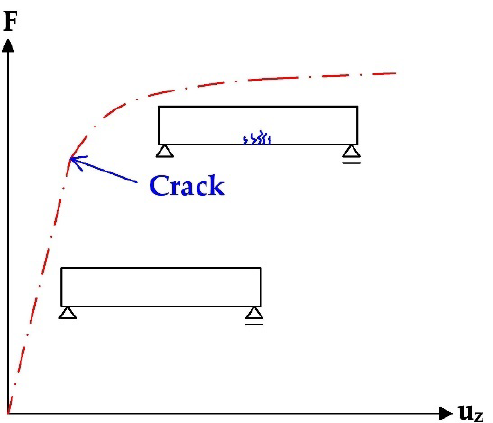
Figure 1. Normal stress distribution in PC member—before sawing ( a ); after sawing ( b ).